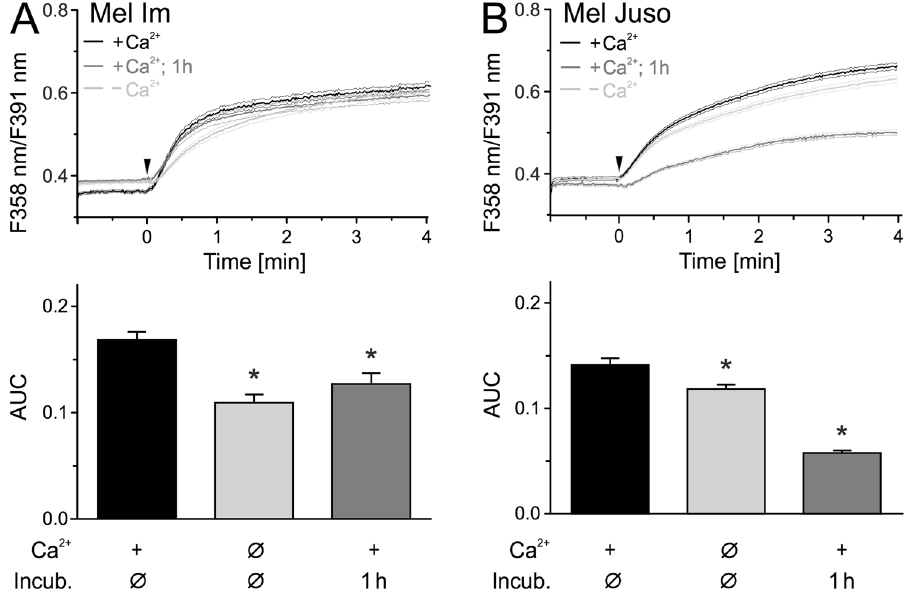
Figure 3. Addition of CAP-pretreated solution onto cells leads to an immediate Ca 2 + influx. Measurement of cytoplasmic Ca 2 + using fura-2 AM. CAP exposed pbECS (100 µ l) with Ca 2 + was applied (black traces) onto Mel Im (( A ), n = 485) and Mel Juso (( B ), n = 321) 1 min after start of recording (arrowhead). The experiment was repeated with an interval of 1 h between CAP-exposure and application of the solutions (dark grey traces) and in the absence of extracellular Ca 2 + (light grey trace) (( A ), n = 274–411; ( B ), n = 366–579). Data are shown as mean and 99% confidence